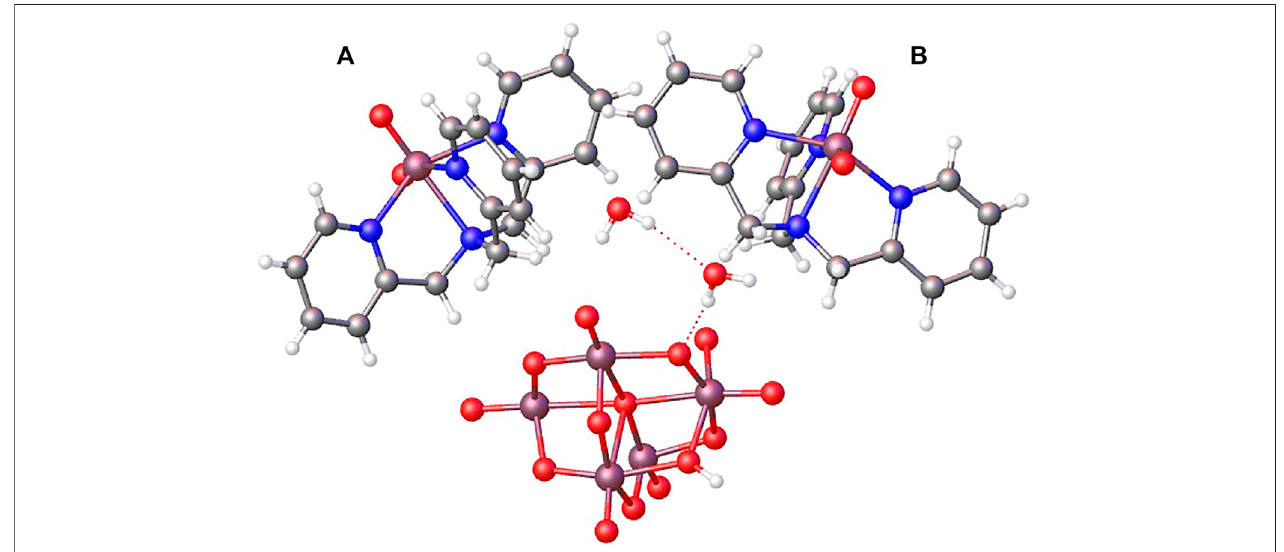
FIGURE1 | OLEX representation of theasymmetric unit containing halfofthe diprotonated decavanadate, two slightly different dioxidovanadium(V) tpma moieties (A,B) , and two crystallization water molecules.